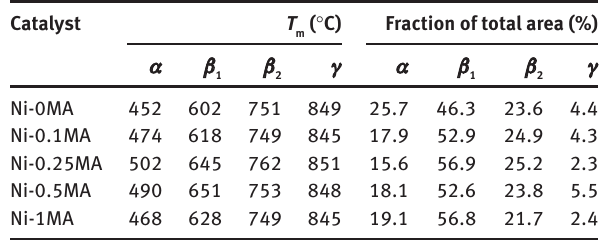
-TPR quantitative data of the Table 3: H 2